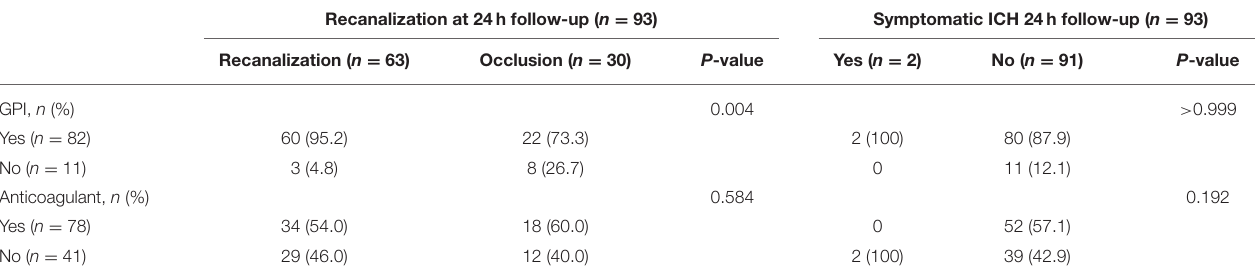
TABLE 2 | Relationships of glycoprotein IIb/IIIa inhibitor or anticoagulant use to traget vessel patency and symptomatic ICH in MT-failed recanalization patients. Recanalization at 24h follow-up ( n = 93) Symptomatic ICH 24h follow-up ( n = 93) Recanalization ( n = 63)